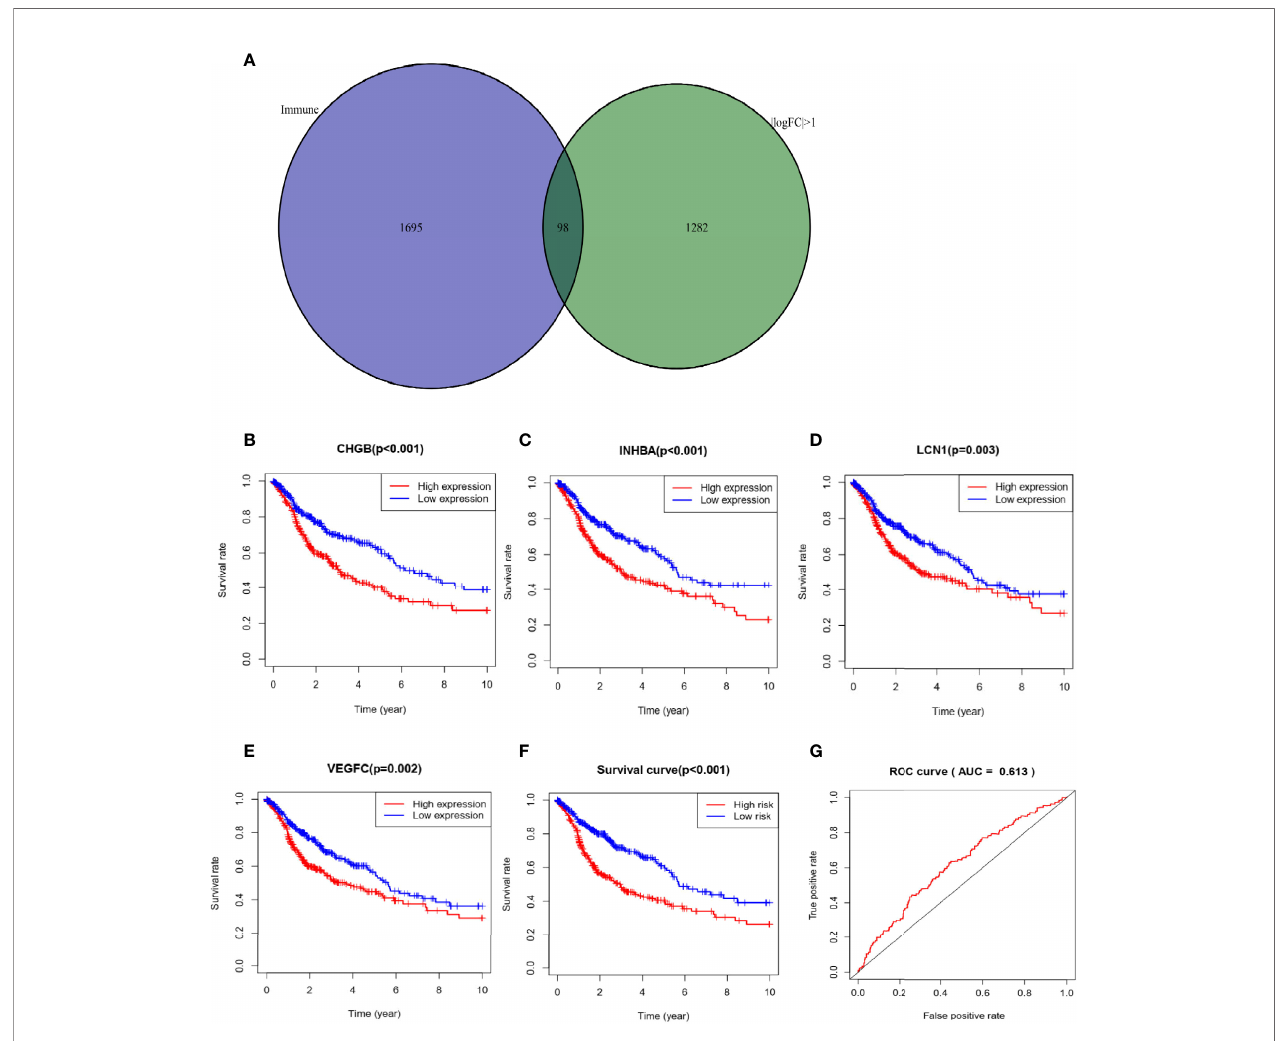
FIGURE 5 | Construction of prognostic model for SCC (A) Immune-related DEGs was shown in Venn plot. (B – E) High expression of hub genes was associated with poor prognosis. (F) The high-risk group had worse prognosis. (G) The area under the curve (AUC) was